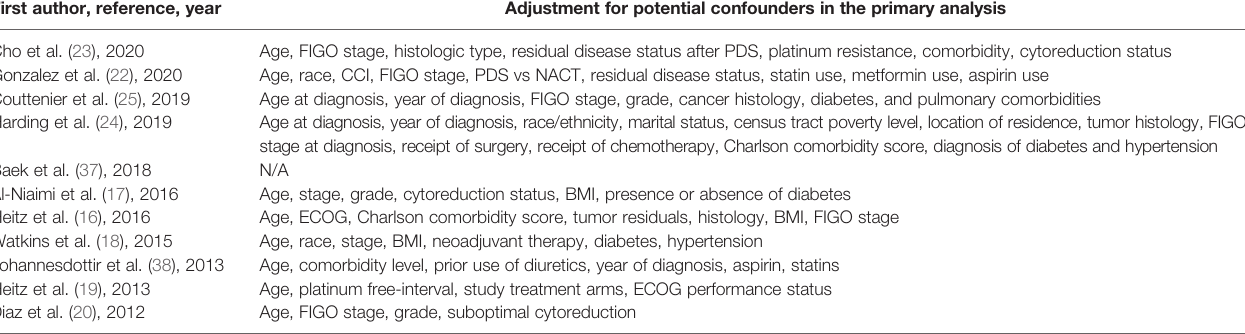
TABLE 2 | Adjustment potential confounders of included studies.